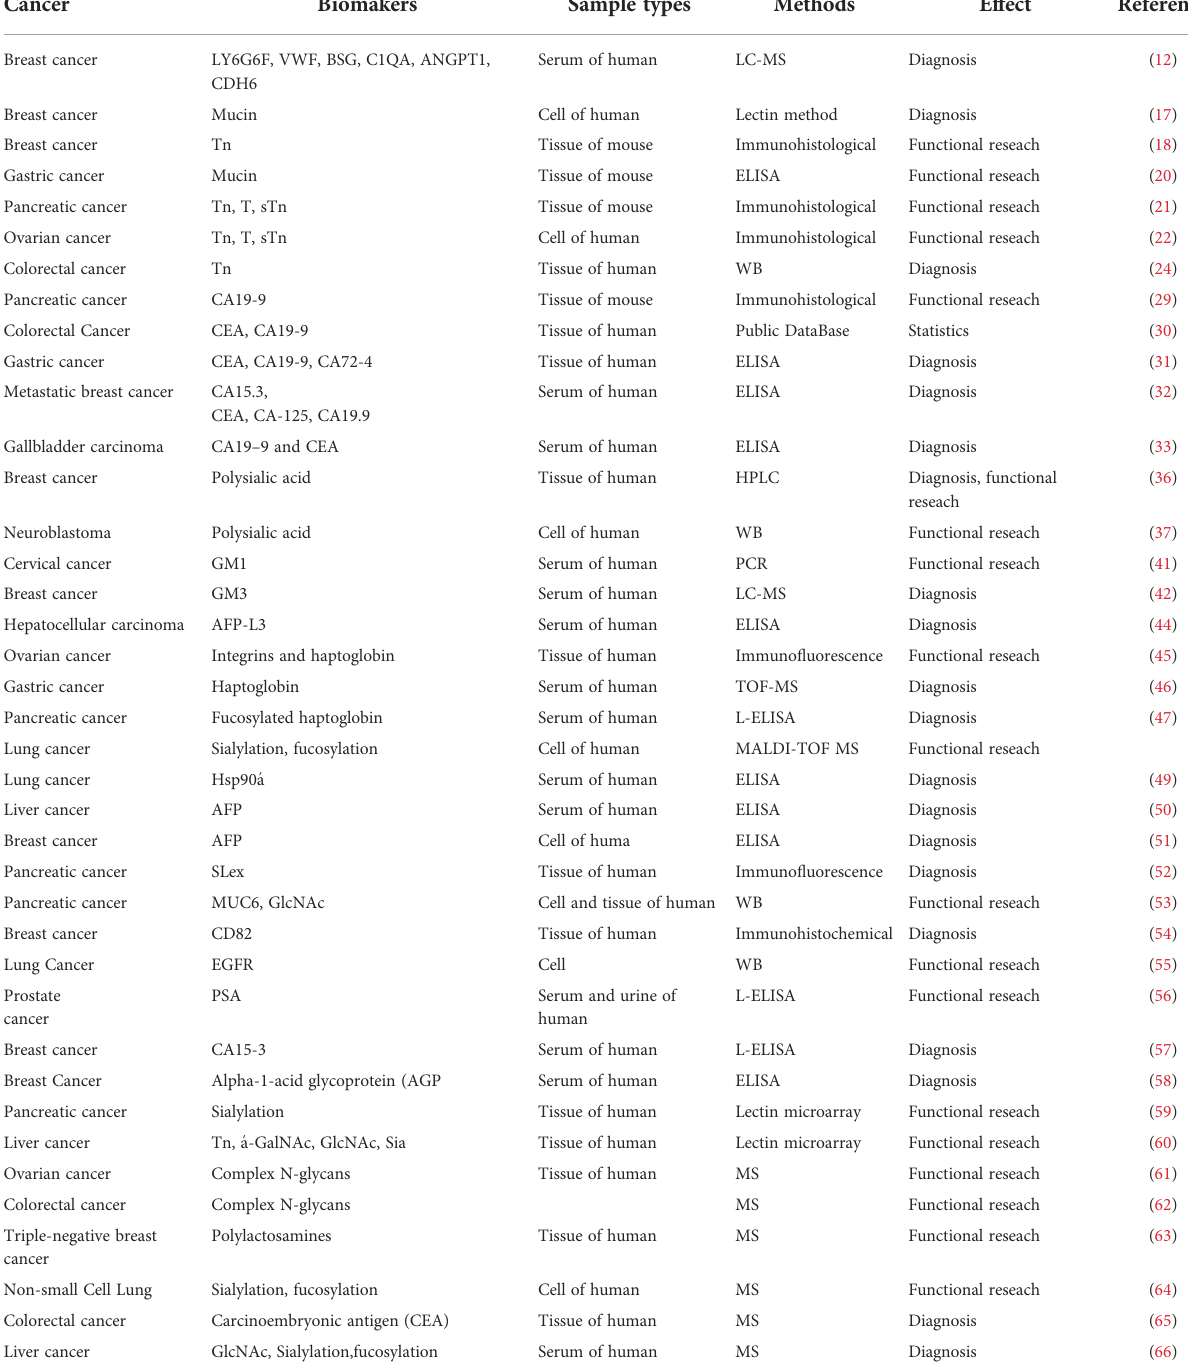
TABLE 1 Representative glycosylated protein or glycan biomarkers in